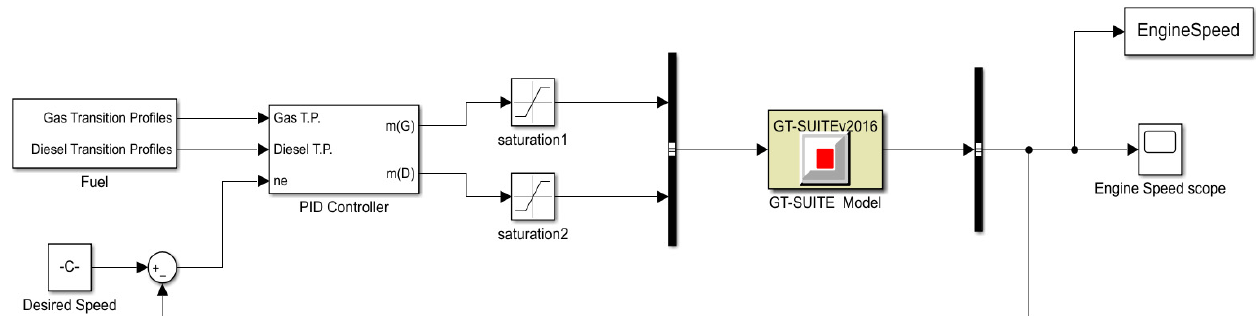
Figure 3. Co-simulation model.